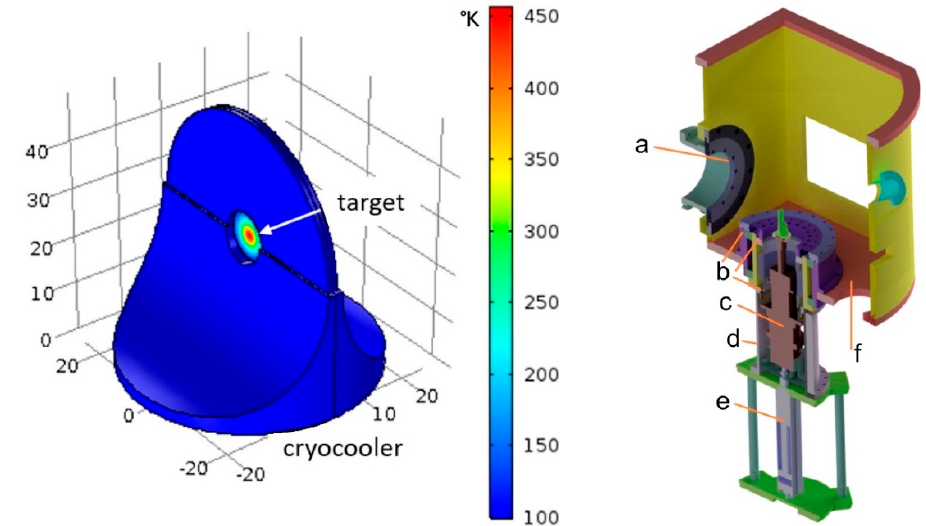
Figure 4. Left : Simulation of the temperature distribution on a 116 Sn target and its holder with a 50 µ A beam of 18 O at 15 MeV / amu. The temperature does not exceed the fusion point. Right : 3D sketch of the target cryocooler in the scattering chamber. (a) connection flange to the forward beam pipe; (b) vacuum seal housing; (c) cryorefrigerator; (d) cylindrical guide for vertical motion; (e) vertical actuator; (f) chamber base platform.